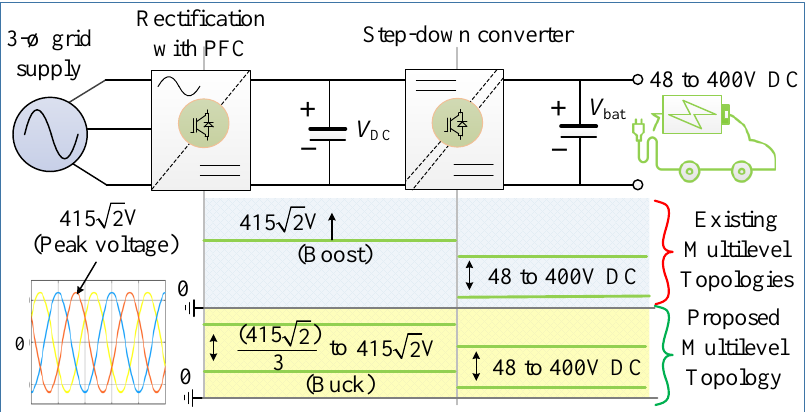
Figure 2. A general representation of voltage levels in two-stage EV charging interface with the conventional and proposed rectifier topologies.